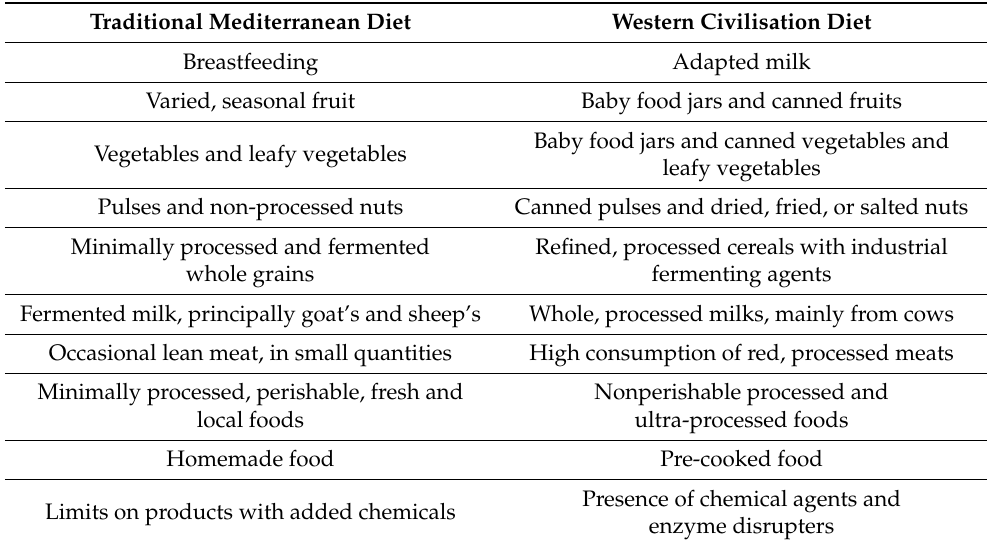
Table 1. Differences between the traditional Mediterranean diet and the “Western civilisation” diet.